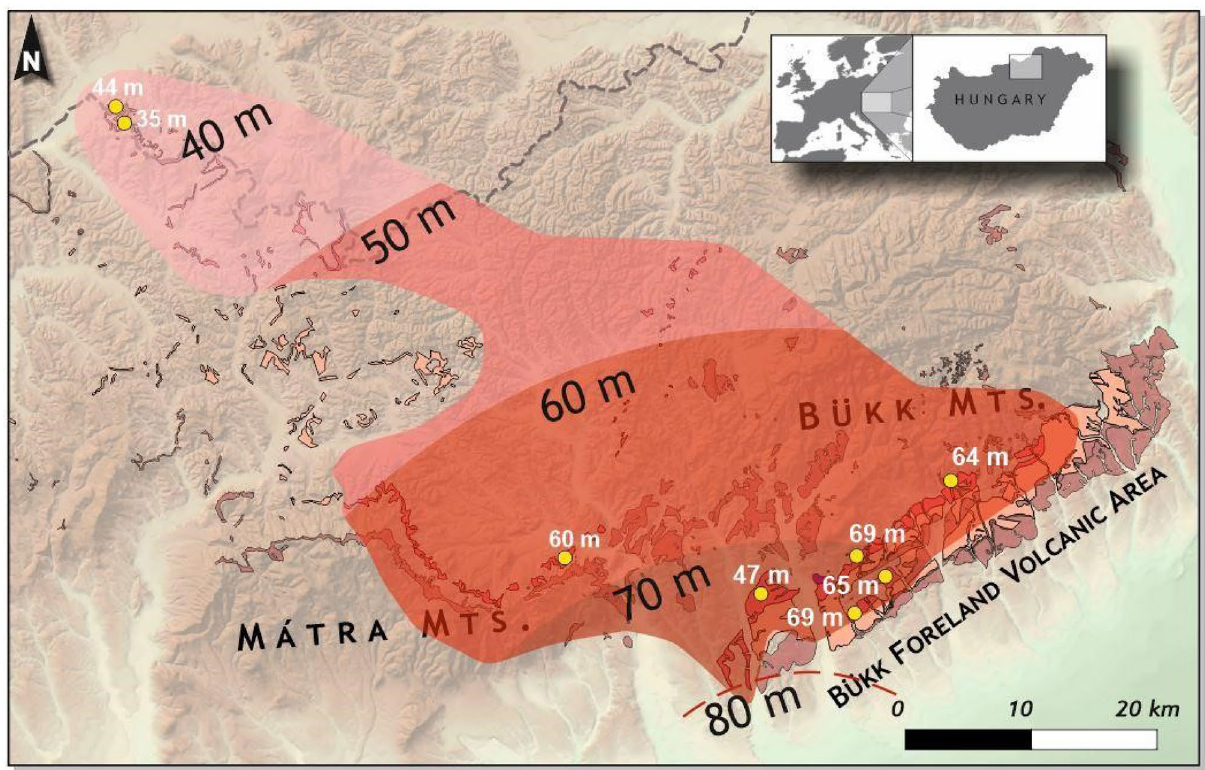
Figure 4. Volumetry of the Eger-Ipolytarnóc Ignimbrite. Based on the scattered surface occurrences, the extrapolated area of the pyroclastic deposits belonging to the Eger-Ipolytarnóc eruption (draped over the shaded relief image of 50 m DEM of Hungary) currently covers ~ 1650 km 2 . (Image created with Surfer 13, version 13.0.383 Golden Software). The neotectonic subsidence of the area south of the Bükk Foreland 22 (including the probable source area: Fig. 1B, and the Great Hungarian Plain further southward) has left only a part of the pyroclastic deposits, ranging from medial to distal, on the surface. However, for some occurrences (yellow dots), total ignimbrite thickness can be observed or inferred. On this basis, assuming uniform thinning to the distal Ipolytarnóc locality (with an observed thickness of 40 m; extrapolated thickness values indicated), the outlined area defines a bulk tephra volume of c. 99 km 3 , which may correspond to c. 58 km 3 DRE (original magma volume), and points to a high-end VEI = 7 eruption (for details of calculation, see Supplement 5). Obviously, the present-day distribution is confined within a disjointed sector; original dimensions were probably much